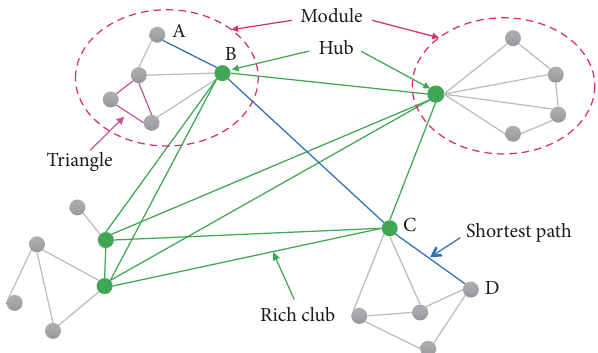
Figure 2: An example of a simple binary undirected network